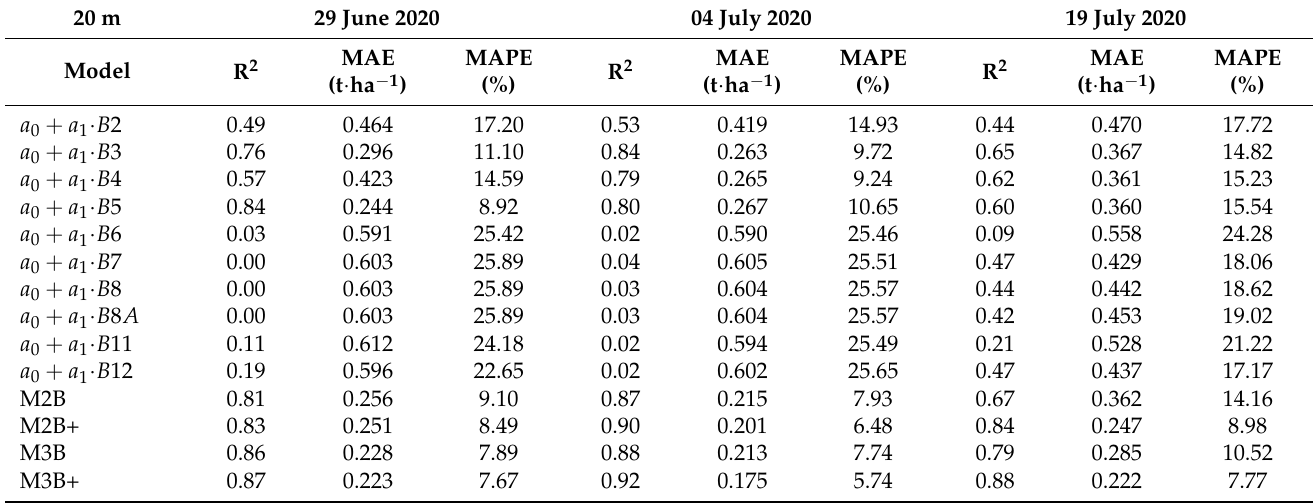
Table A4. Bomba 20 m spatial resolution model evaluation with training data (model coefficients are different for each